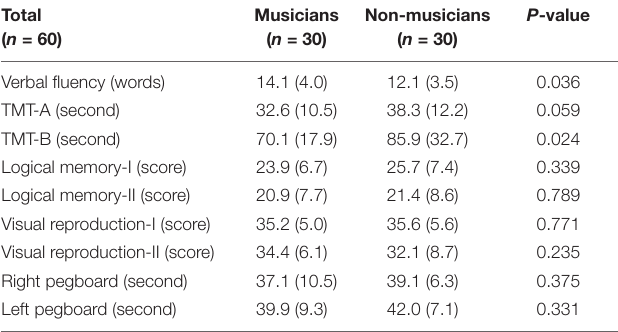
TABLE 4 | Behavioral results in both groups.